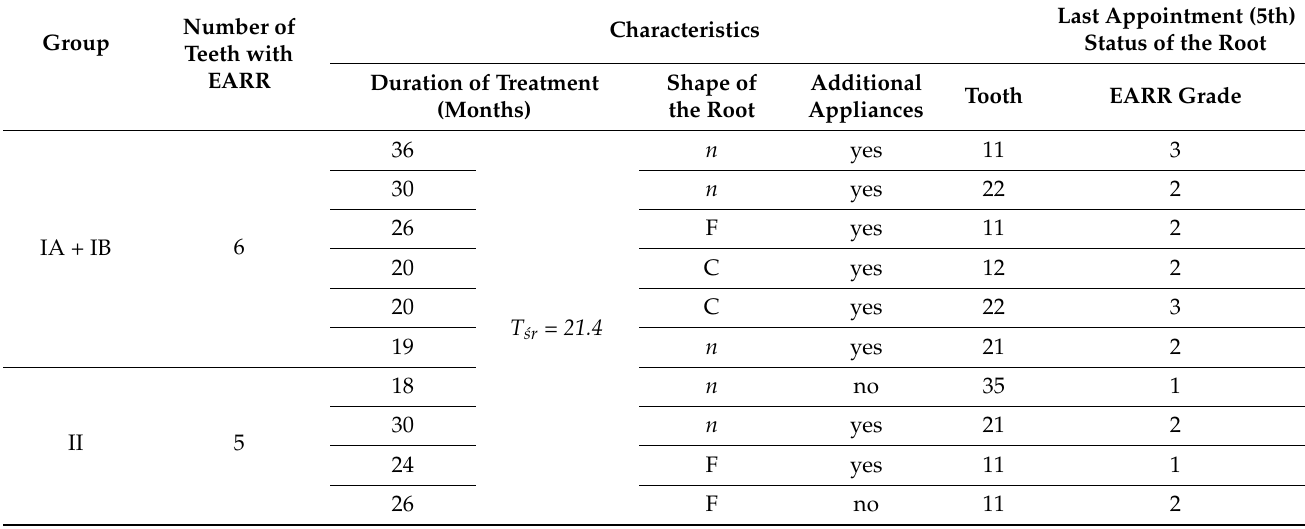
Table 8. Characteristics of teeth with detected root